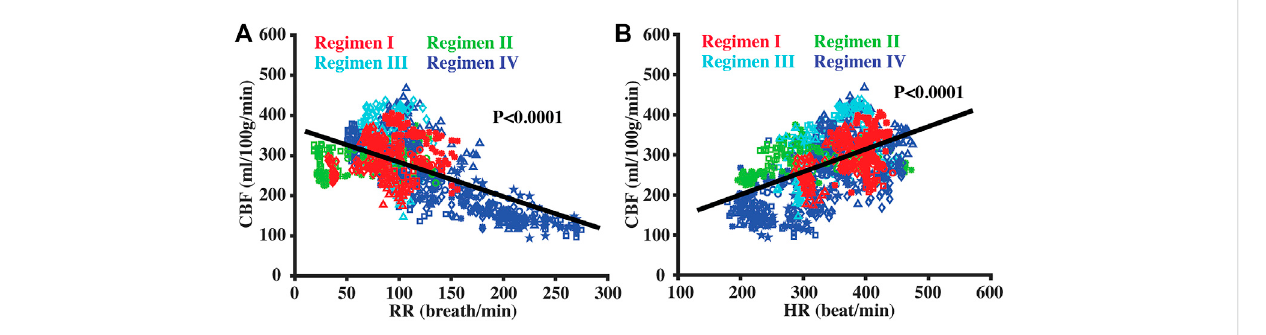
FIGURE 7 Scatter plots between CBF and RR (A) and between CBF and HR (B) . Red, green, cyan, and blue symbols corresponded to data collected under Regimens I, II, III, and IV, respectively. Solid lines denoted the fi tted equations with linear regression